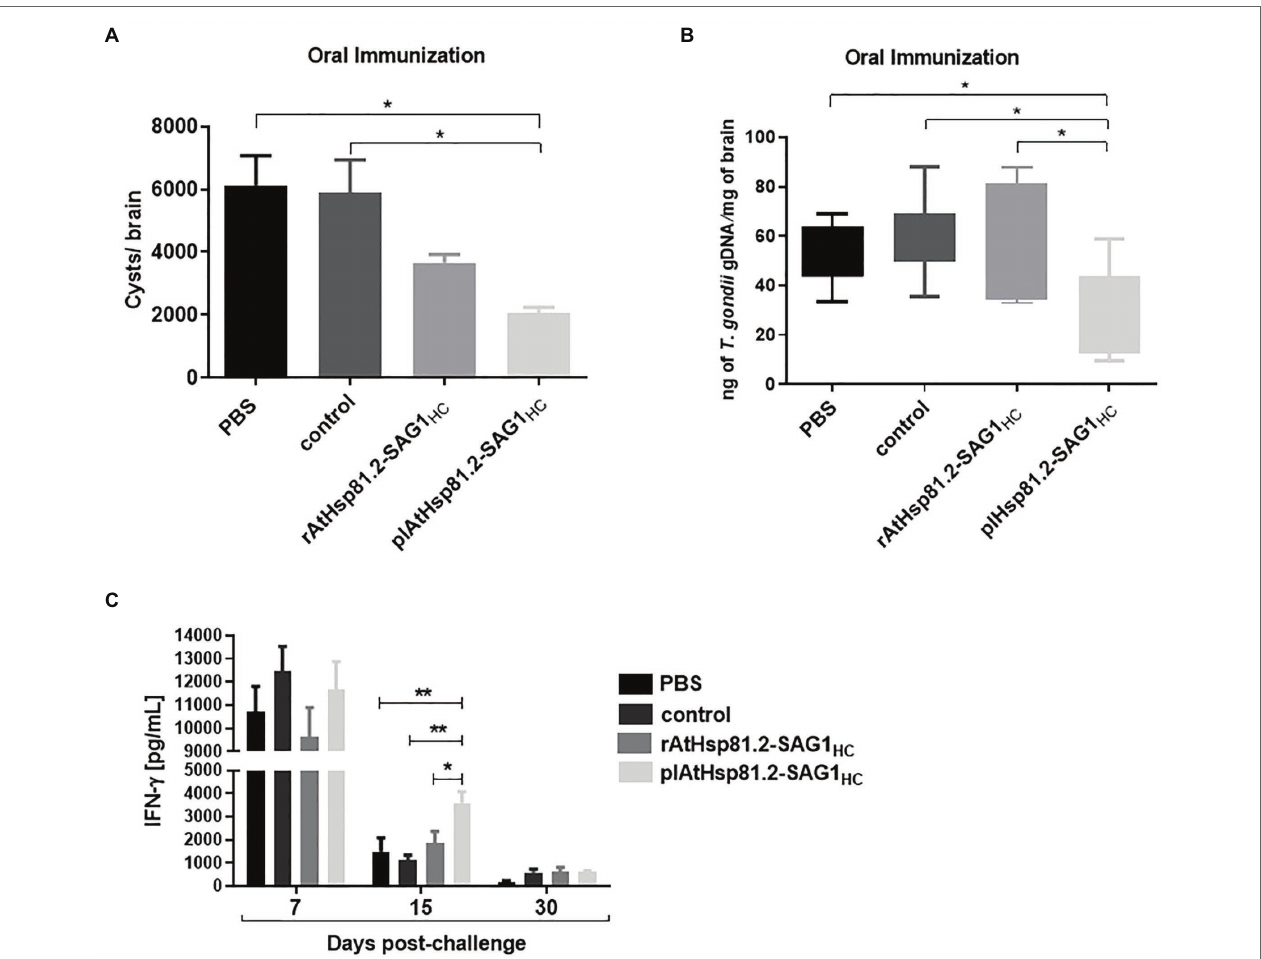
FIGURE 7 | Analysis in orally immunized mice after Toxoplasma gondii infection. (A) Cyst number per brain. (B) Cerebral parasite burden assessed by quantitative PCR (qPCR). Results are expressed as ng parasite genomic DNA per mg of brain tissue. (C) Values of interferon (IFN)- γ in serum samples (five mice per group) at 7, 15 (acute infection), and 30 (chronic infection) days after mice were challenged with the cysts. Serum samples were diluted 1:20, and IFN- γ was measured using ELISA. plAtHsp81.2-SAG1 HC : mice vaccinated with AtHsp81.2-SAG1 HC -infiltrated leaf extracts, rAtHsp81.2-SAG1 HC : mice vaccinated with rAtHsp81.2–SAG1HC purified from AtHsp81.2-SAG1 HC -infiltrated leaves, control: mice vaccinated with non-infiltrated leaf extracts, PBS: mice vaccinated with phosphate-buffered saline 1X. Two weeks after the last boost, mice were challenged by gavages with 20 cysts of the Me49 strain. Each bar represents the group mean ± standard error of the mean (SEM). One-way ANOVA was performed using Holm-Sidak’s multiple comparisons test and Tukey’s multiple comparisons test. * p < 0.05; ** p <